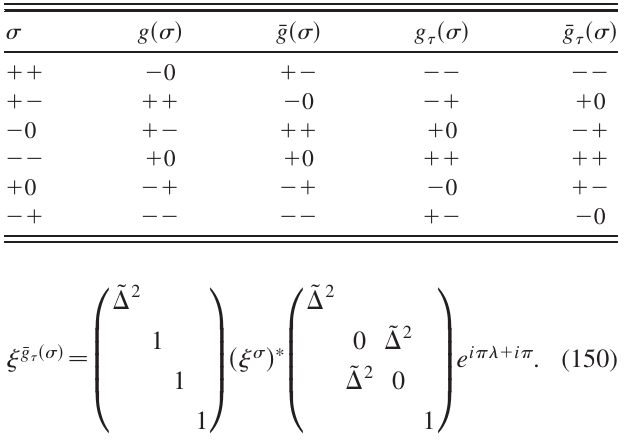
TABLE VI. The effect of various operations on the three- quasihole configuration (cid:10) . g ð (cid:10) Þ is the resulting configuration when a quasihole is dragged around the torus along an a -type path (as shown in Fig. 6 for two quasiholes), and (cid:1) g ð (cid:10) Þ is the same for a b -type path. The rightmost and topmost